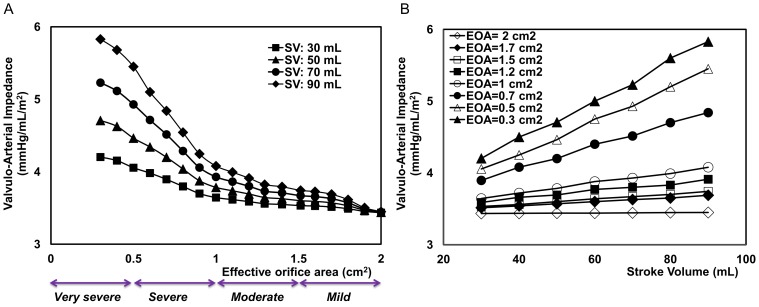
Dependency of valvulo-arterial impedance to effective orifice area and stroke volume.(a) as a function of effective orifice area (EOA), (b) as a function of stroke volume for normal arterial pressure.